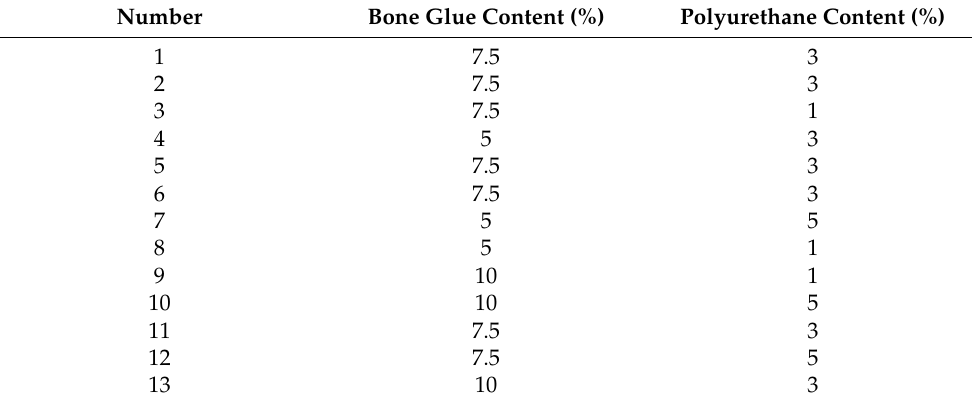
Table 4. Contents of bone glue and